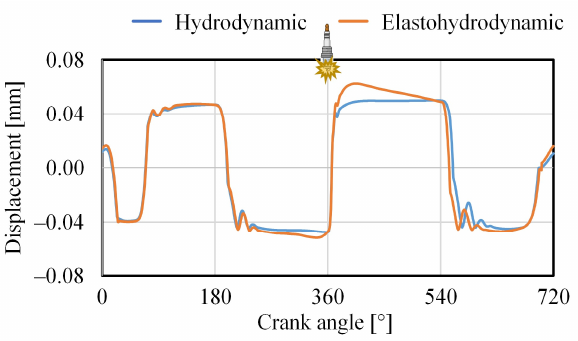
Figure 10. Piston lateral displacement dependent on the crankshaft angular position. The firing occurs near a crank angle of 360°.